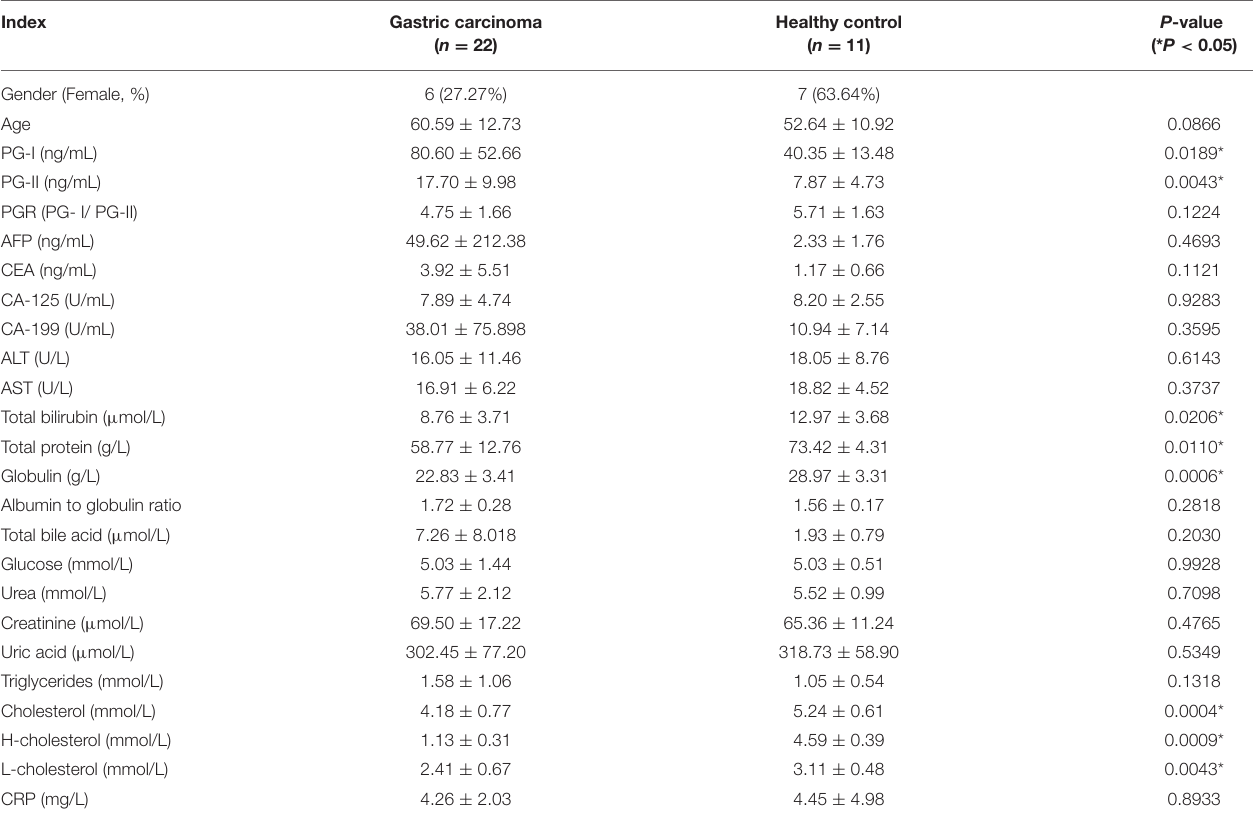
TABLE 1 | Demographic and clinical details of